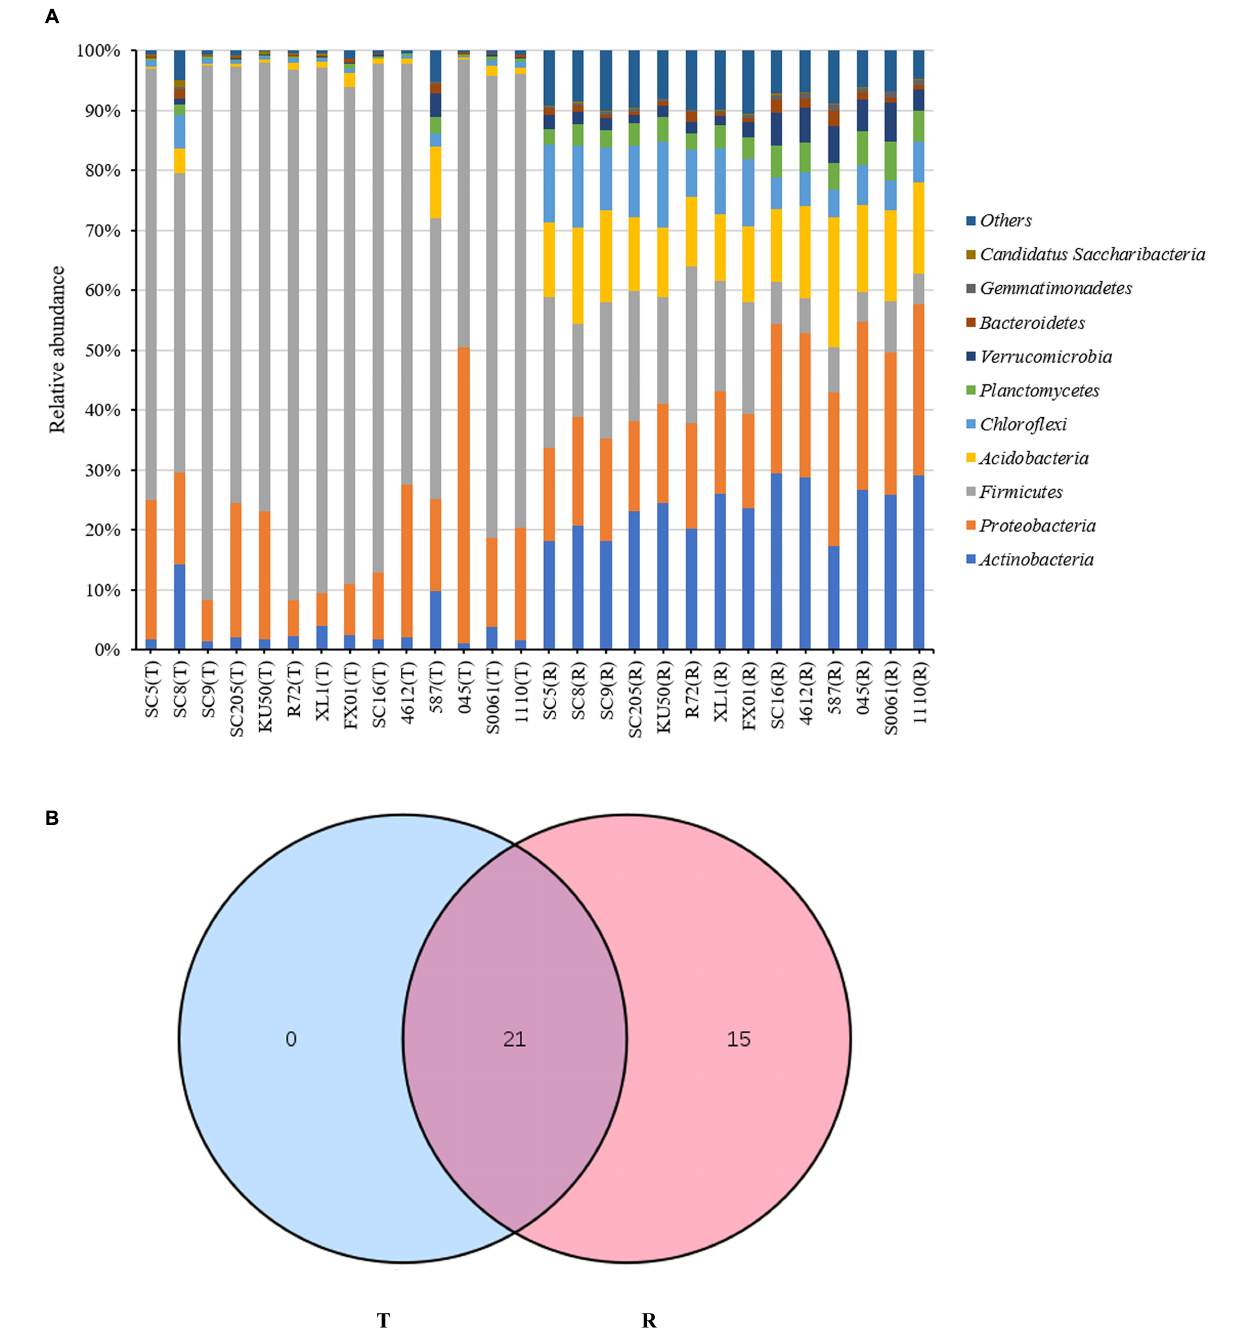
FIGURE 1 | (A) Histogram of the relative abundances at the phyla level of the TOP 10 bacterial communities. (B) Number of bacterial phyla in tuberous roots and rhizosphere soil of different cassava genotypes. T stands for tuberous roots; R stands for rhizosphere.